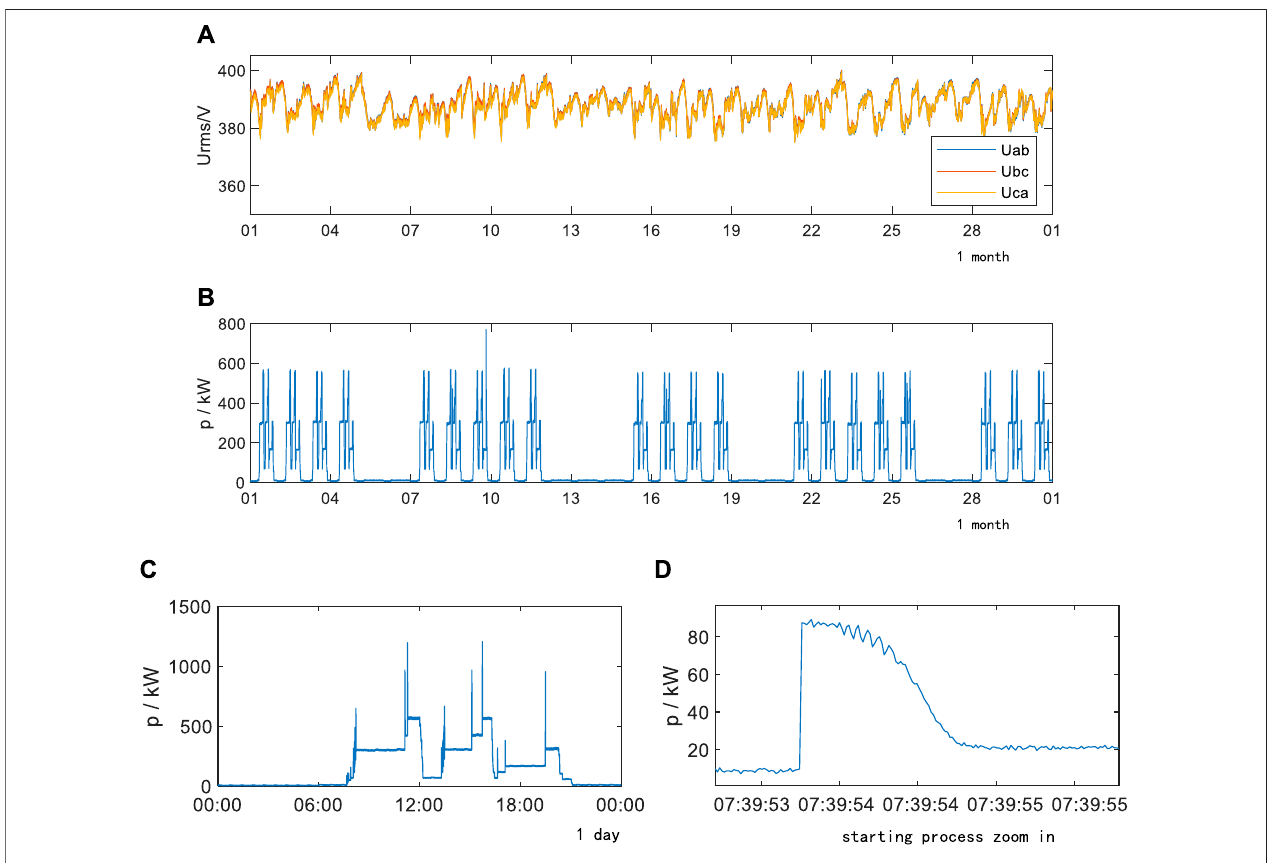
FIGURE 9 | Data of the study case: (A) voltage root-mean-square (RMS) curve; (B) instantaneous power for 1 month; (C) instantaneous power for 1 day; (D) instantaneous power of one device in its start-up process.